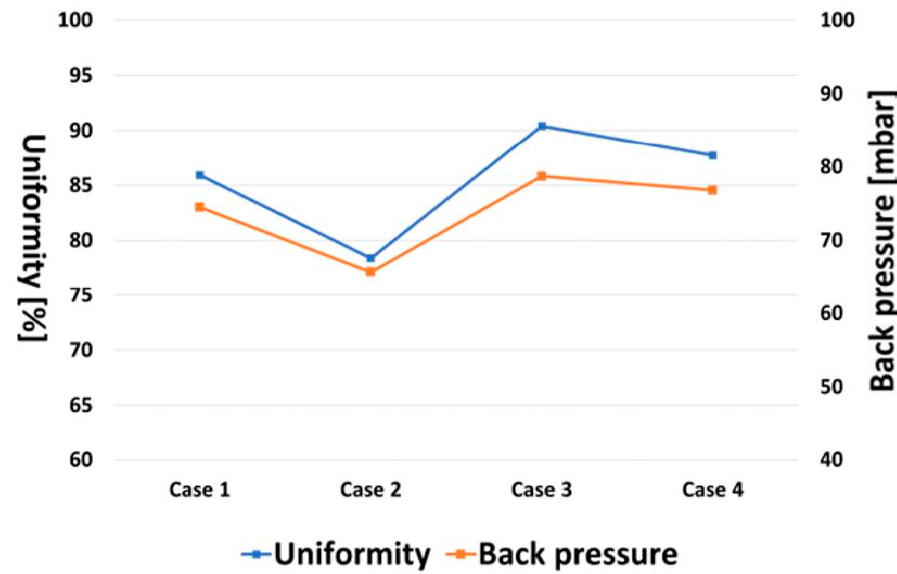
Figure 8. Correlation between uniformity, back pressure, and urea injector locations.